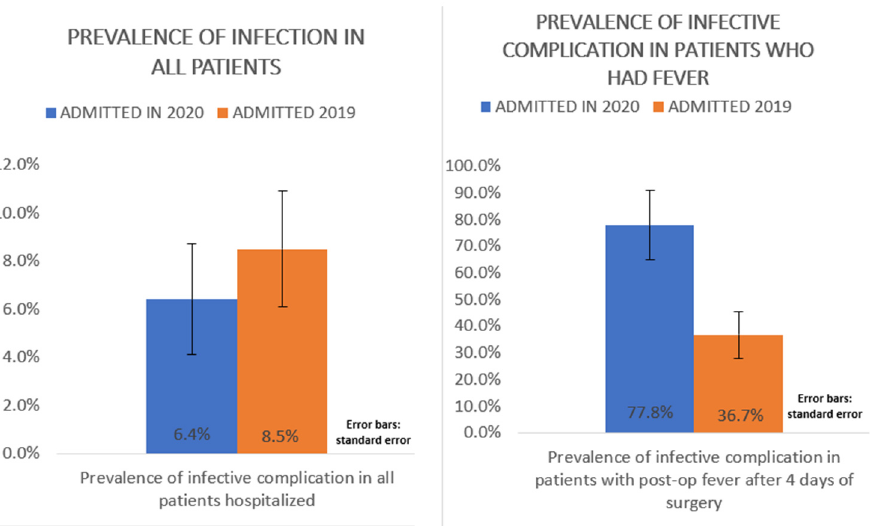
Figure 2. Difference between prevalence of infective complications in all patients hospitalized and in patients who had post-op fever after 4 days of surgery.